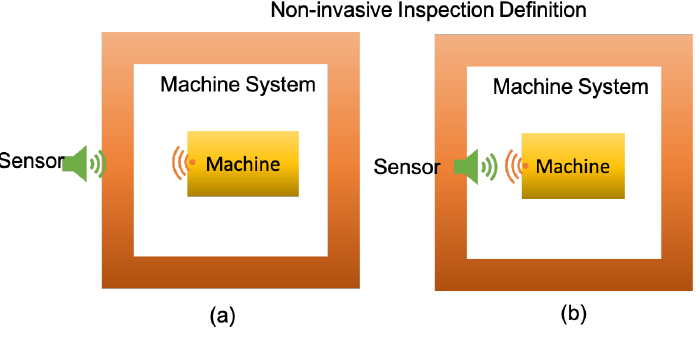
Figure 1. Non-Invasive definition ( a ) non-contact based and ( b ) contact